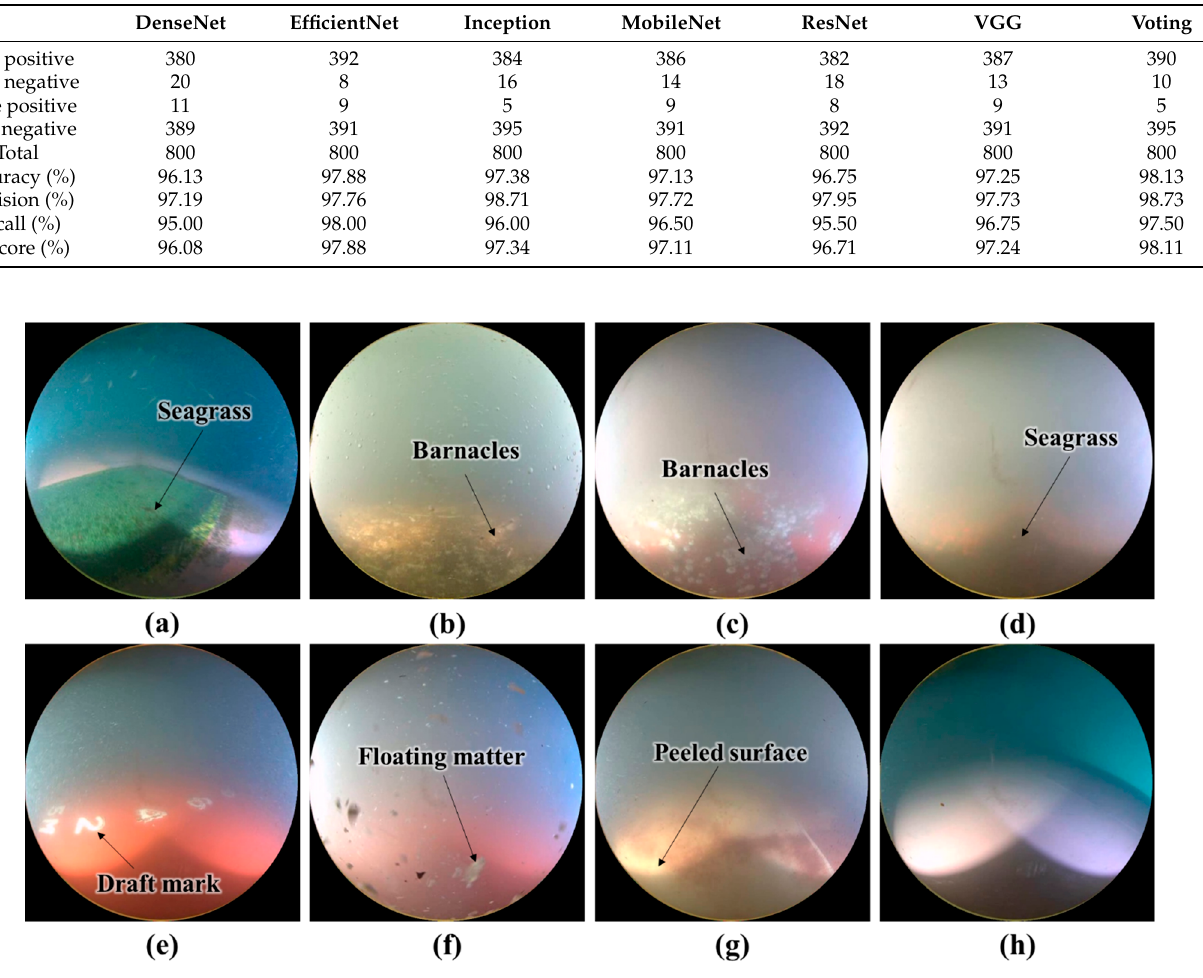
unclean and ( e – h ) images classified as clean.